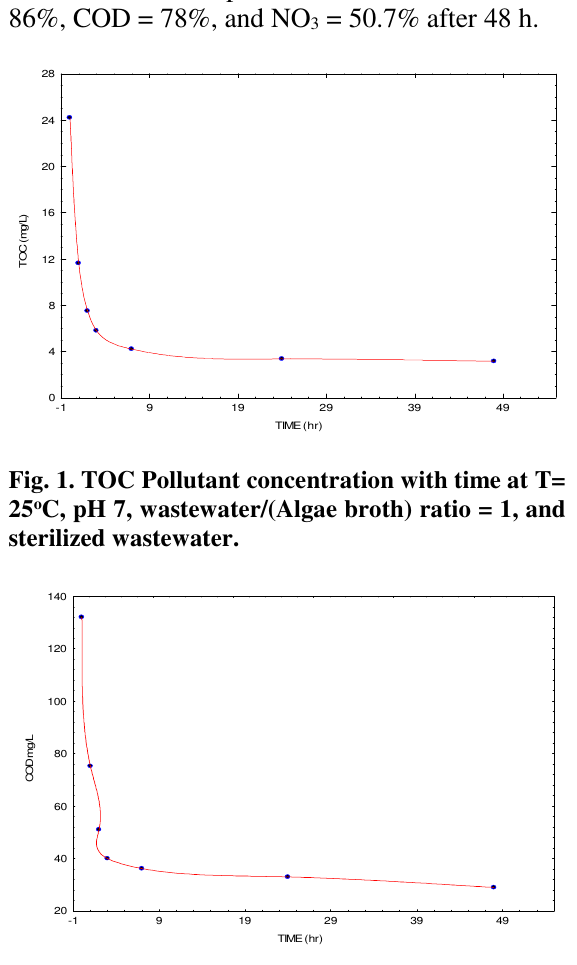
Fig. 2. COD Pollutant concentration with time at T= 25 o C, pH 7, wastewater/(Algae broth) ratio = 1, and sterilized wastewater.